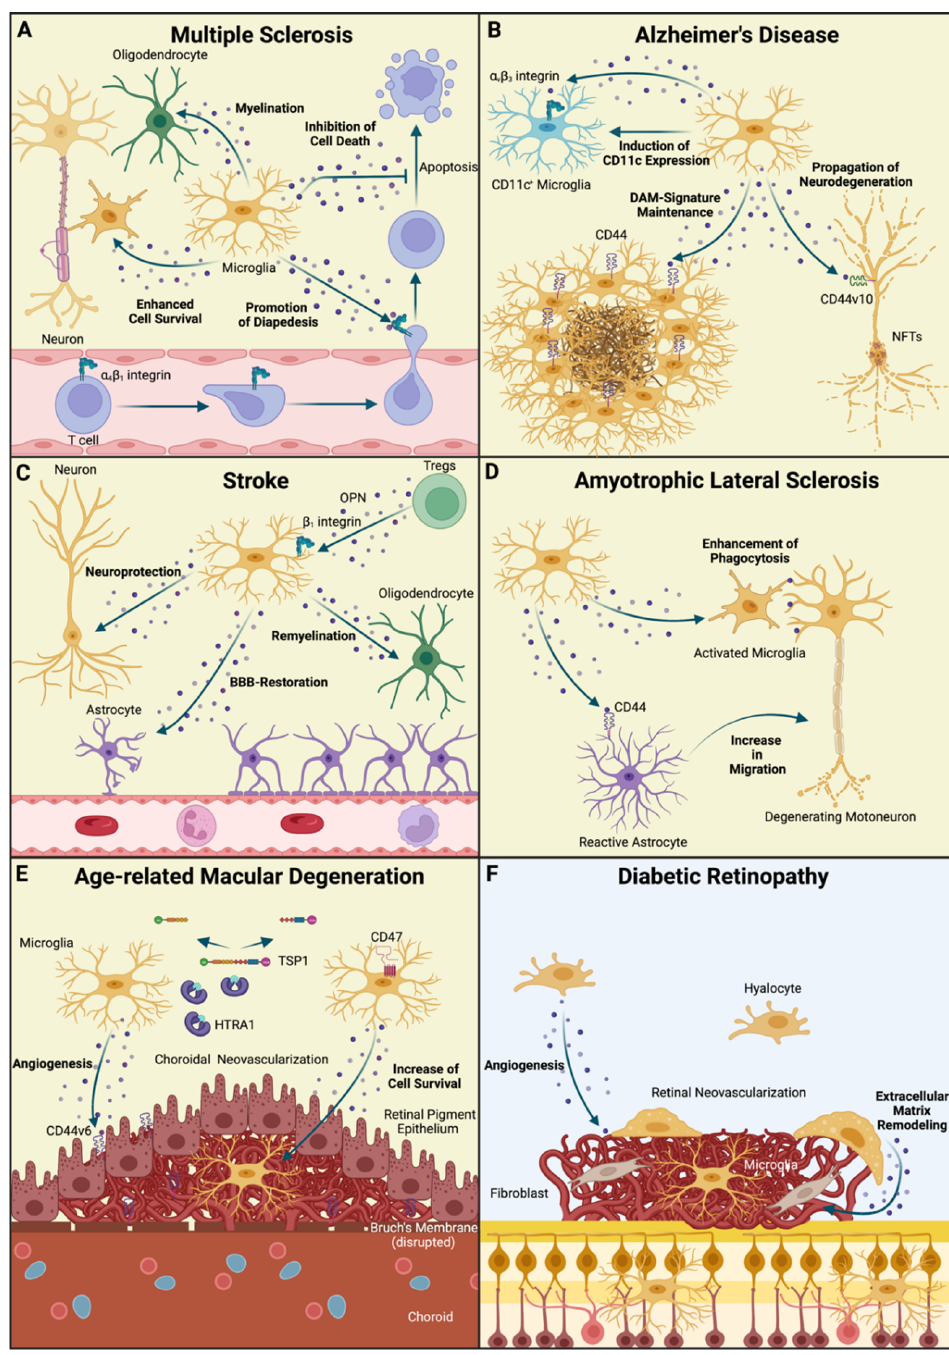
Figure 3. The Interplay between Microglia and OPN in CNS Pathology. ( A ) In MS, microglia-derived OPN (blue dots) promotes the influx of adaptive immune cells, including T cells whose survival is enhanced upon exposure to OPN (variants of OPN are indicated by gradual color differences and symbol size). Microglia increase their survival through OPN secretion in an autocrine and paracrine manner and stimulate myelination and oligodendrogenesis. ( B ) In AD, OPN is responsible for the acquisition and maintenance of the DAM signature and the CD11c-related phenotype of a microglia subset that is linked to amyloid plaques, here surrounded by disease-associated microglia (DAM). The OPN-dependent engagement of CD44v10 on neurons, enriched with neurofibrillary tangles (NFTs), may further propagate neuron cell death and hence contribute to neurodegeneration in AD. ( C ) In the context of stroke, the β 1 integrin-mediated interaction between Tregs and microglia promotes remyelination and oligodendrogenesis. The restoration of the blood–brain barrier (BBB) is enhanced by OPN and confers neuroprotective effects. ( D ) During ALS development, microglia represent one of the main sources of OPN. OPN facilitates microglia-mediated phagocytosis through various mechanisms, including opsonization. In addition, OPN stimulates the migration of